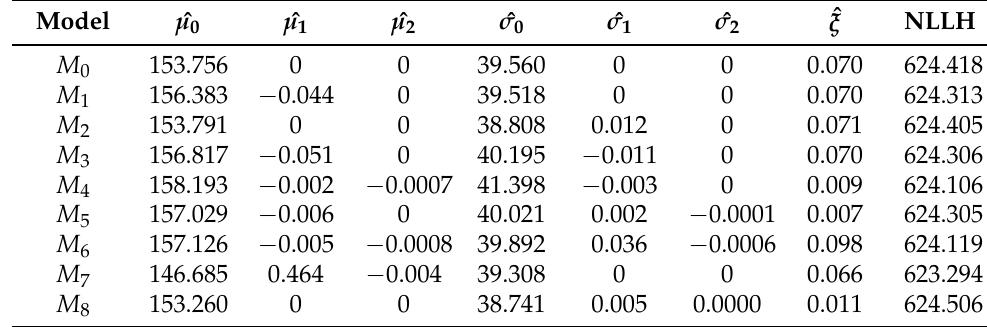
Table 9. Non-stationary GEVD models for KwaZulu-Natal for the period 1900–2017.